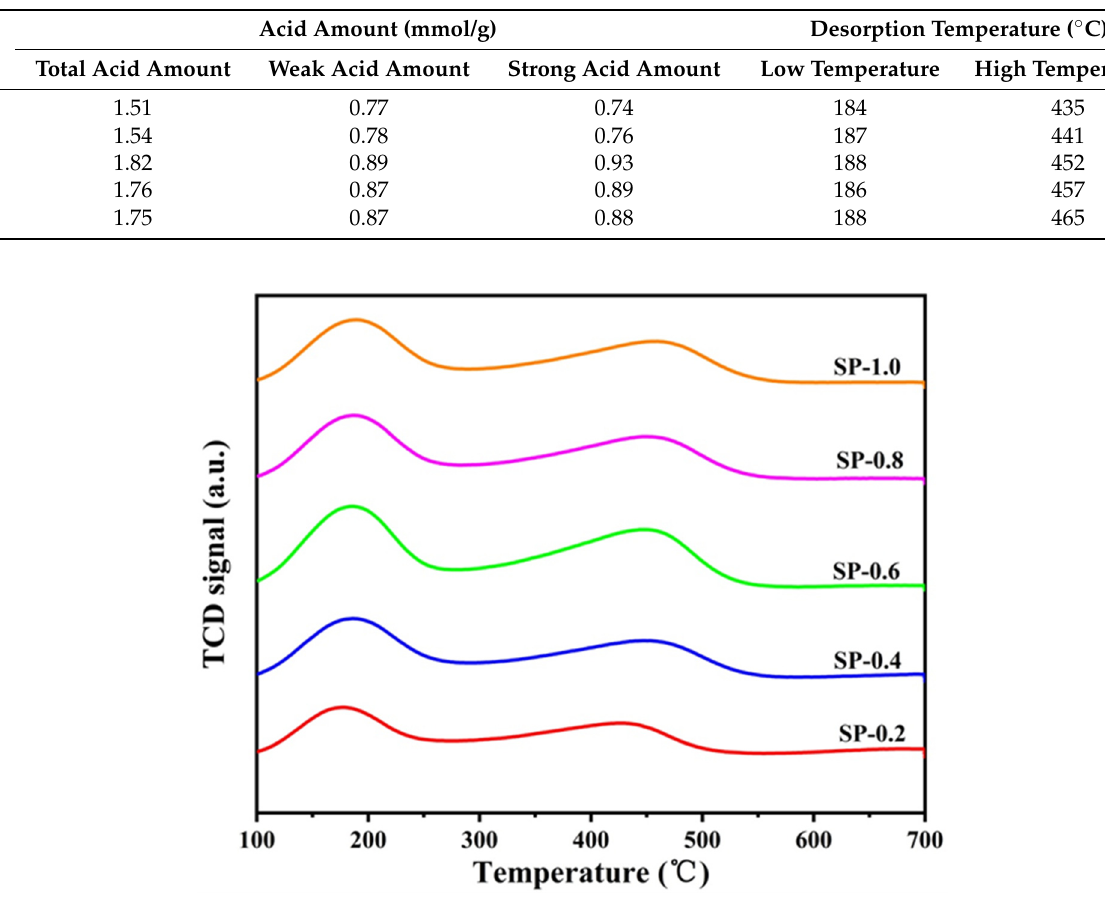
Figure 4. NH 3 -TPD curves of as-synthesized samples. Table 3. The amount of acid sites of as-synthesized samples.